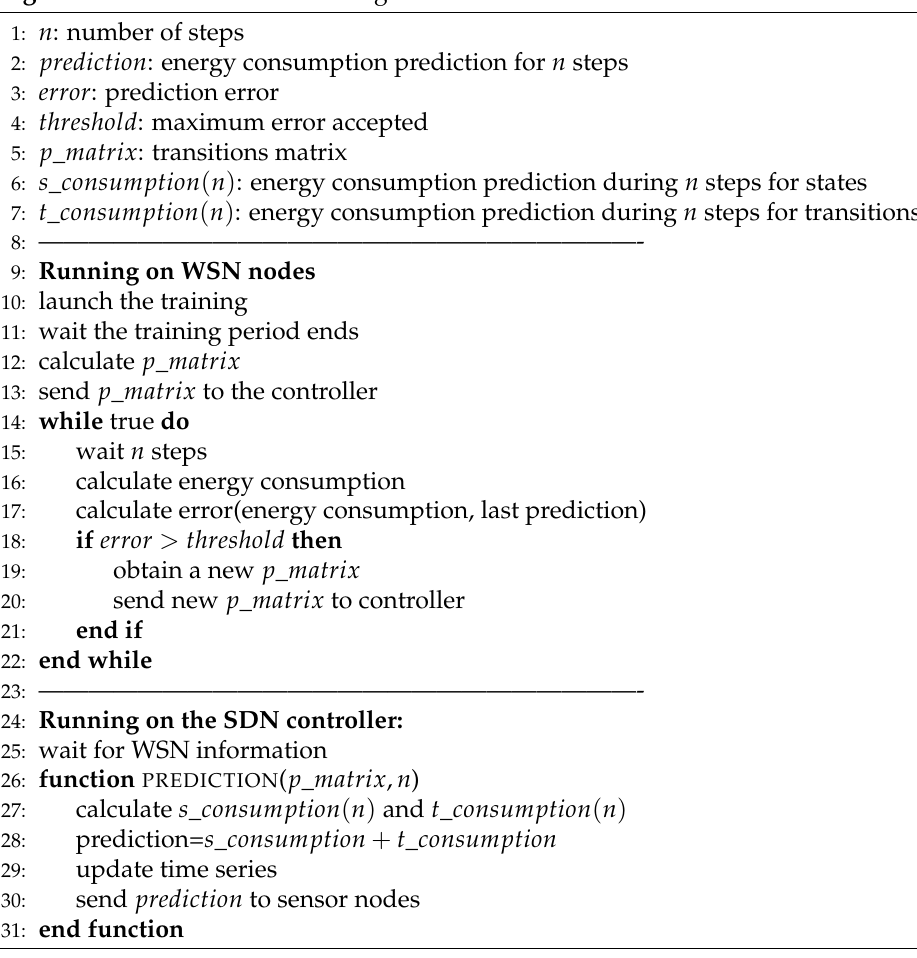
Algorithm 1 Markov chain running on the